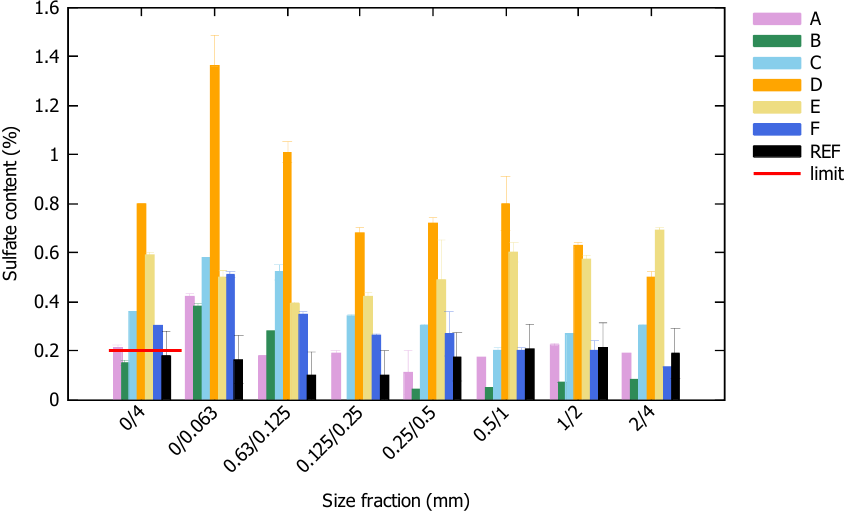
Figure 2. Water soluble sulfate content of the FRA in total and per size fraction. Table 2. Characterization of the used FRA before recomposition and effective values in the mortars after